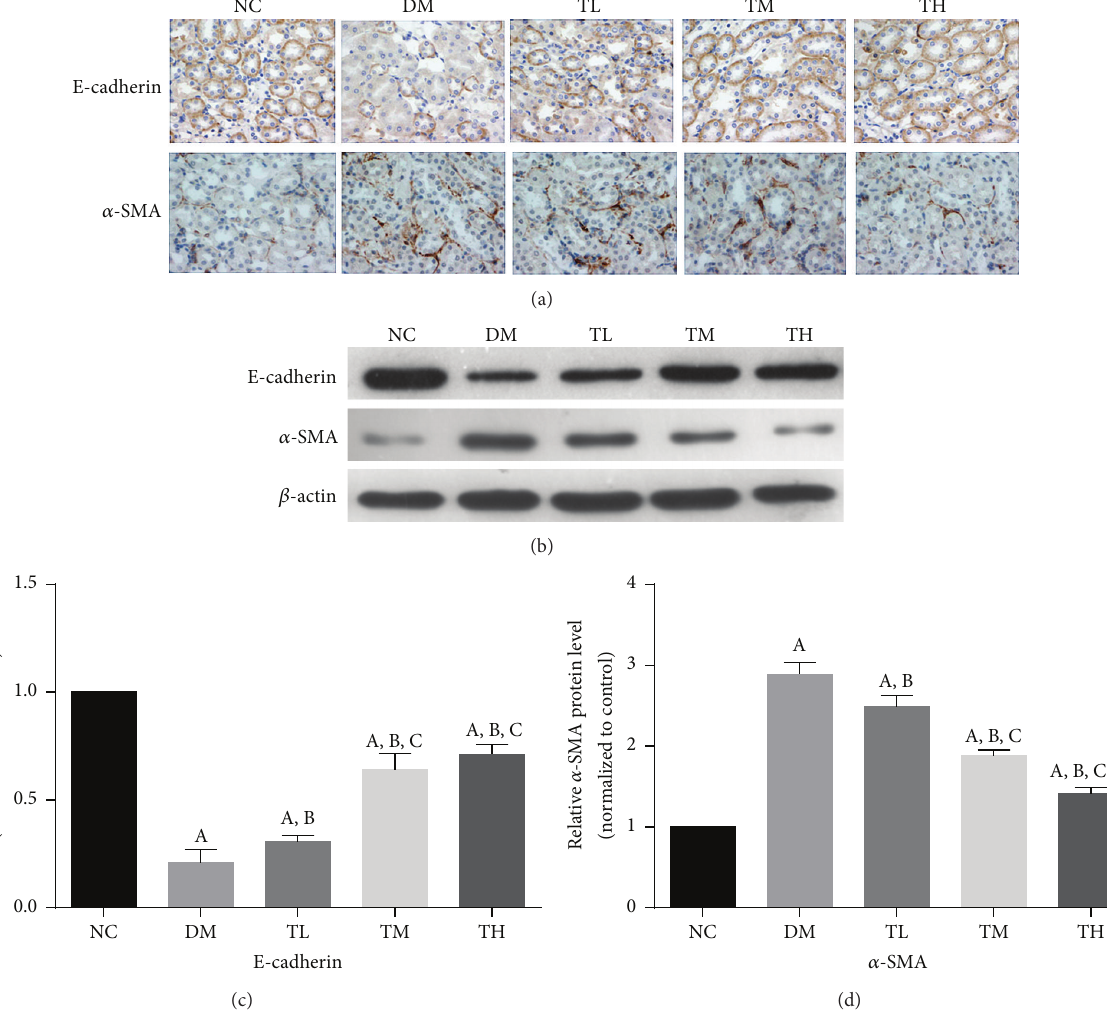
Figure 2: Effect of TGT on E-cadherin and 𝛼 -SMA localization and expression in diabetic rat kidney by immunohistochemistry and western blot.(a)ImmunostainingofE-cadherinand 𝛼 -SMAwasshownfordifferentgroups.(b)RepresentativewesternblottinganalysisofE-cadherin and 𝛼 -SMAwasshownfordifferentgroups.(c-d)DensitometricresultsofE-cadherinand 𝛼 -SMA,asdeterminedbywesternblot.NC:normal control; DM: diabetic rats without drug treatment; TL: low-dose TGT (1mg/kg/day); TM: medium-dose TGT (3mg/kg/day); TH: high-dose TGT (6mg/kg/day). A 𝑝 < 0.05 versus NC group, B 𝑝 < 0.05 versus DM group, C 𝑝 < 0.05 versus TL group, and D 𝑝 < 0.05 versus TM group.